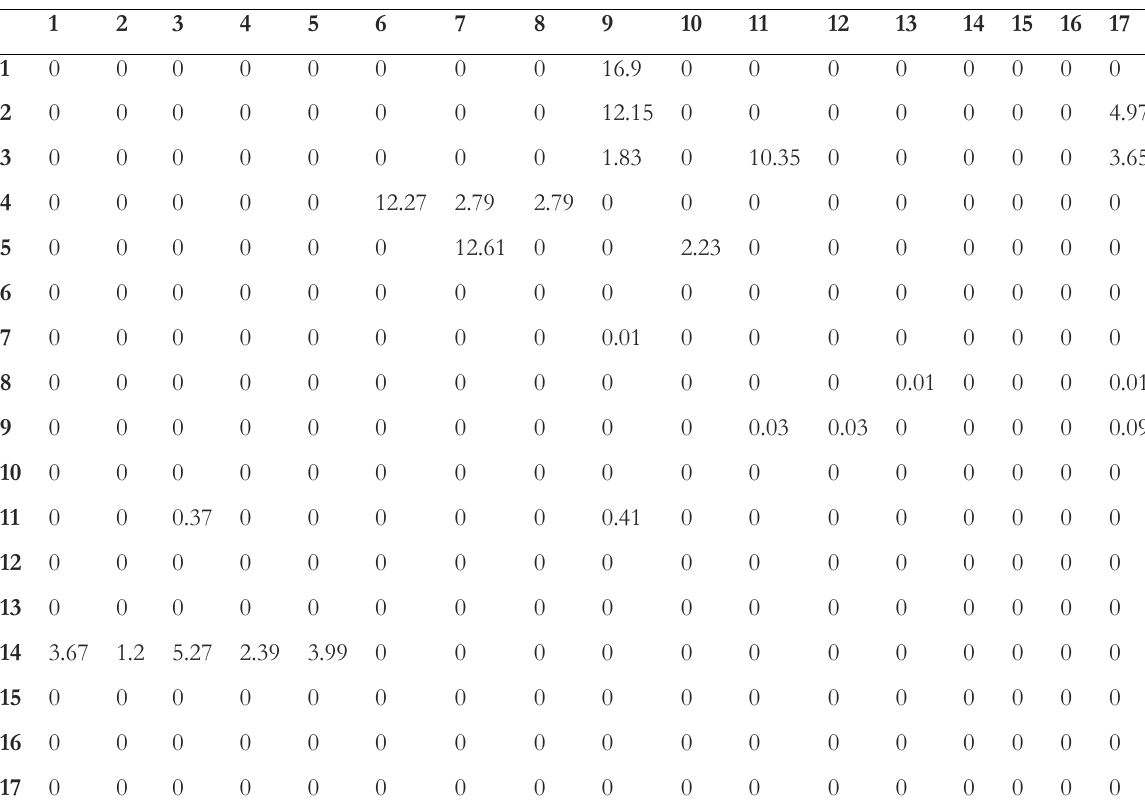
Table 2. Matrix of the transportation percentage among